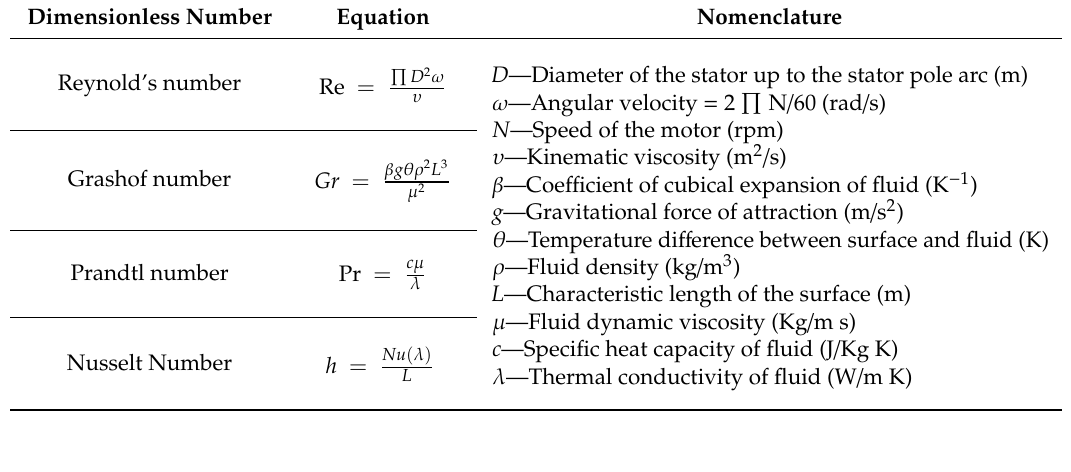
Table 3. Dimensionless parameters to calculate heat transfer coe ffi cient [24].